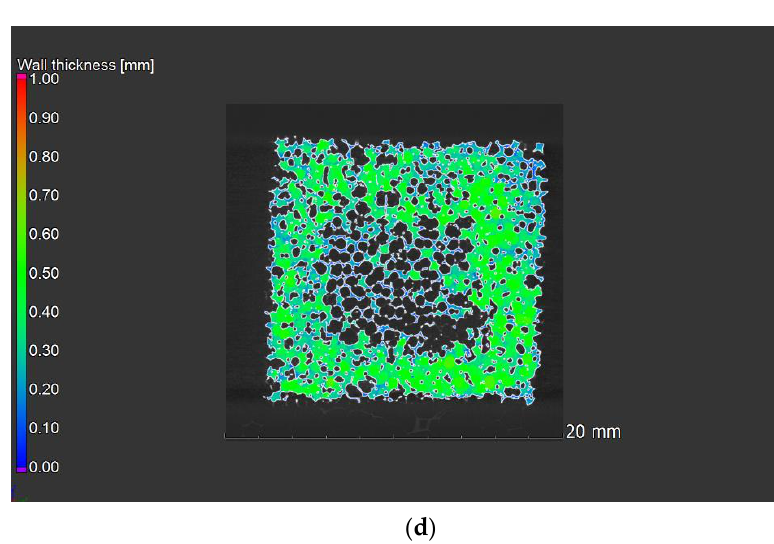
Figure 2. ( a ) Three-dimensional microstructure of typical reticulated porous alumina with a pore density of 80 PPI, prepared under optimized slurry conditions, reconstructed by μ-computed tomography (CT). ( b ) Representative slice taken from the μ-CT reconstructions. ( c ) Three-dimensional microstructure of typical reticulated porous alumina with a pore density of 80 PPI, prepared under un-optimized slurry conditions, reconstructed by μ-CT. ( d ) Representative slice taken from the μ-CT reconstructions.